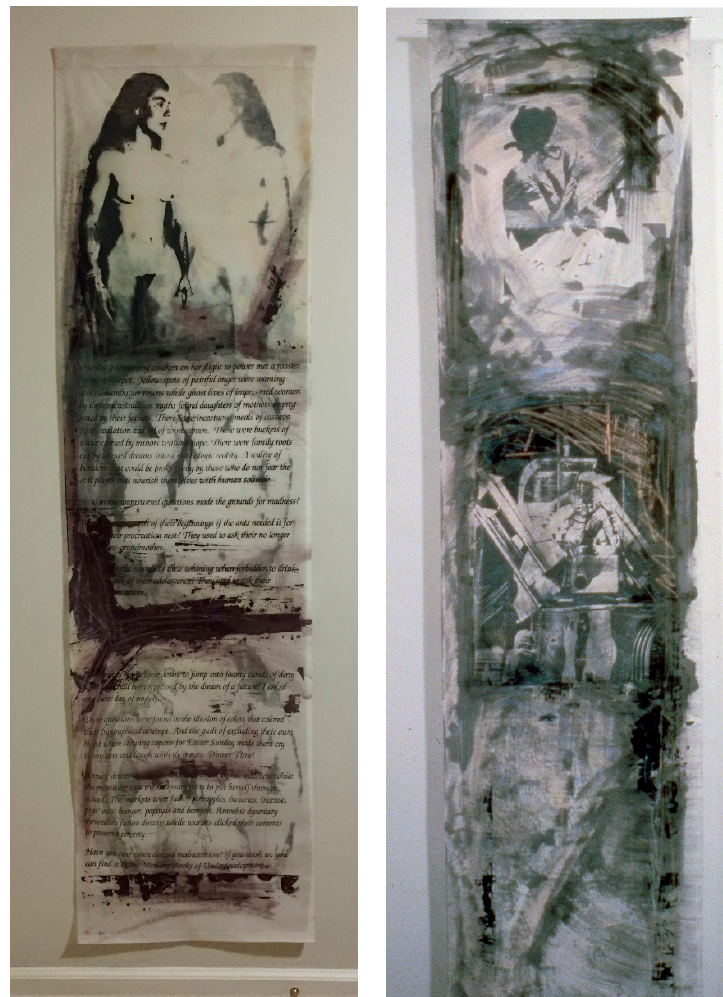
Figure 12. Josely Carvalho, Craters of Blood , 1984, 6 panels of various sizes, silkscreen, crayon, and dyes on silk. Courtesy of the artist.